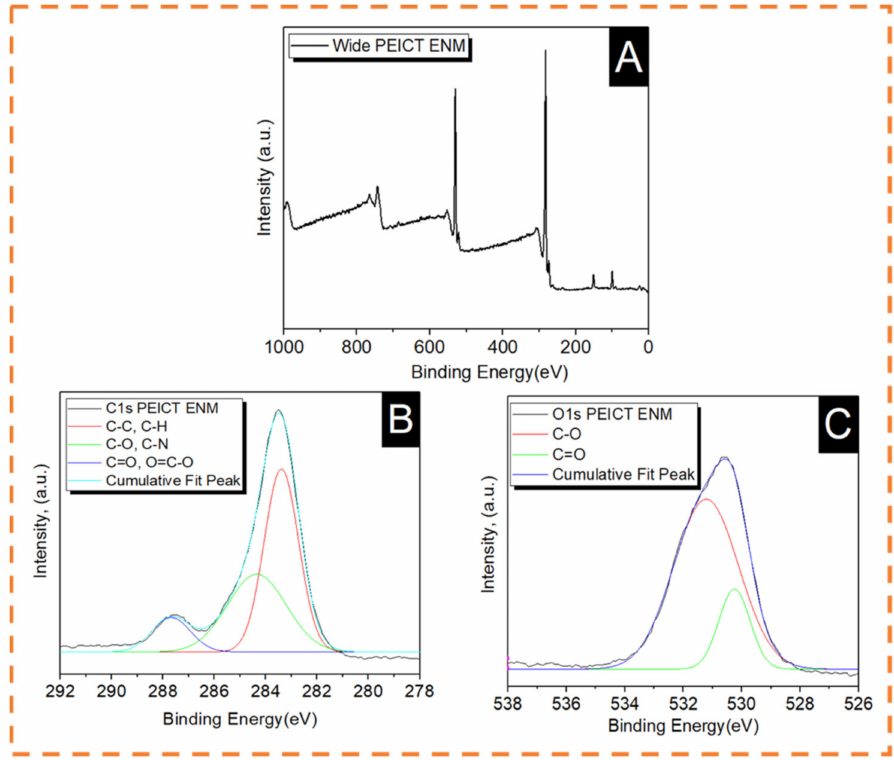
Figure 4. XPS spectra of PEICT ENM. ( A ) Wide spectra. ( B ) Carbon 1s. ( C ) Oxygen 1s.